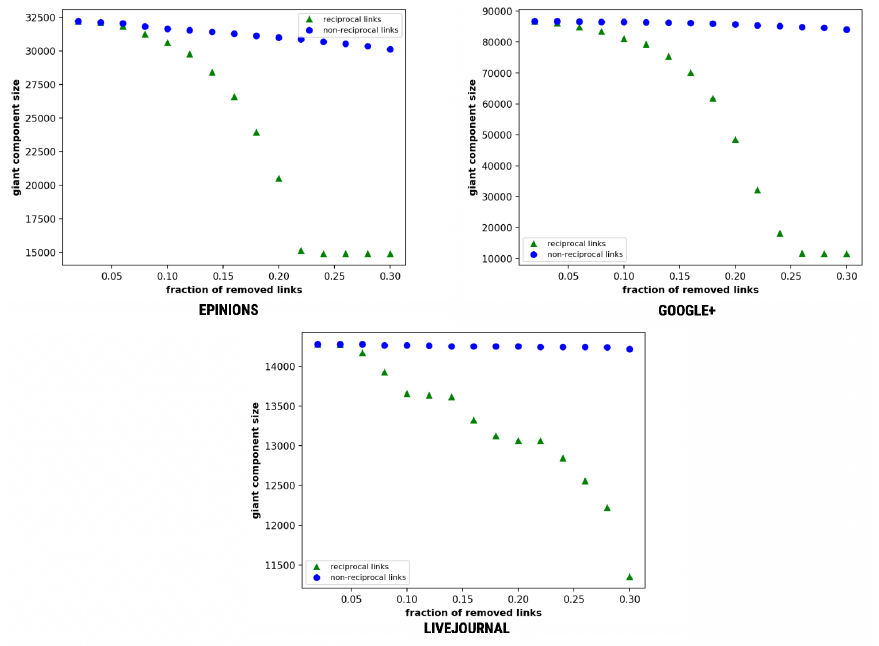
Figure 13. Affected giant component size as a function of the fraction of removed